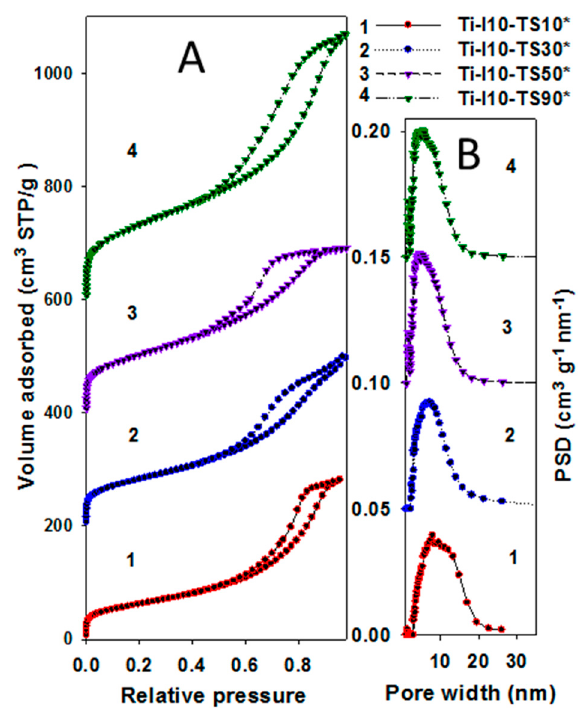
Figure 3. ( A ) N 2 adsorption isotherms and ( B ) the corresponding PSD curves for the Ti-I10-Tx* samples thermally treated at 600 °C (All isotherms and PSD are shifted by multiple of 200 cm 3 STP/g and 0.05 cm 3 g − 1 nm − 1 , respectively).